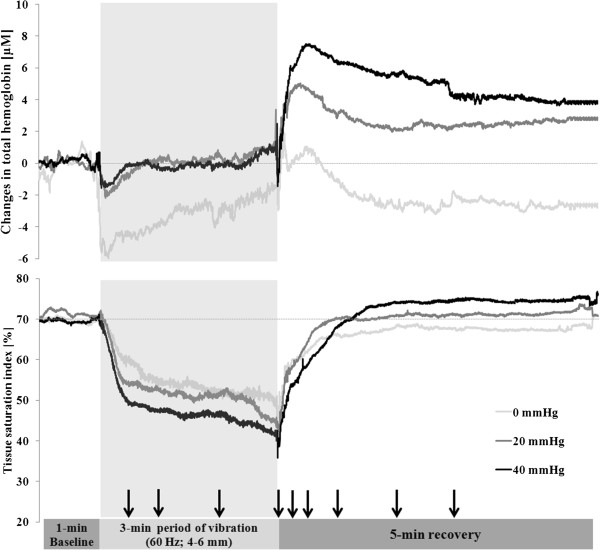
Mean change (n = 12) in the total hemoglobin concentration and tissue saturation index prior to, during and following 3 min in the downhill tuck position with vibration and different levels of compression. For the sake of clarity, we have not illustrated the standard deviations, which were at similar magnitudes with all clothing. The arrows indicate the time-points at which the data collected was subjected to statistical analysis.